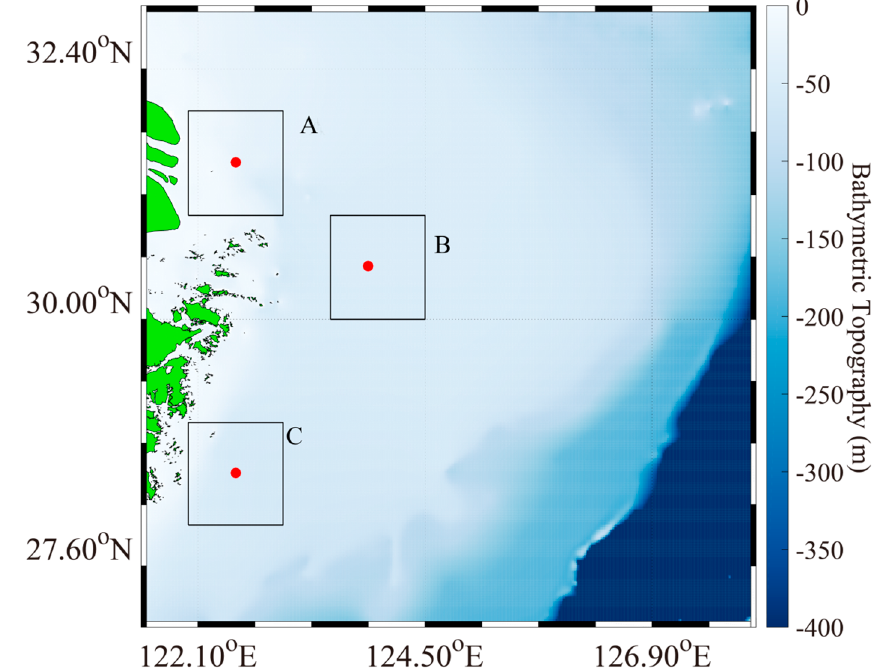
Figure 7. Three typical regions around the Zhoushan Islands used to study the statistical analysis of current speed. Region A is located in the Yangtze Estuary and tidal flats. The three red spots represent the three representative specific locations for studying the extreme waves.